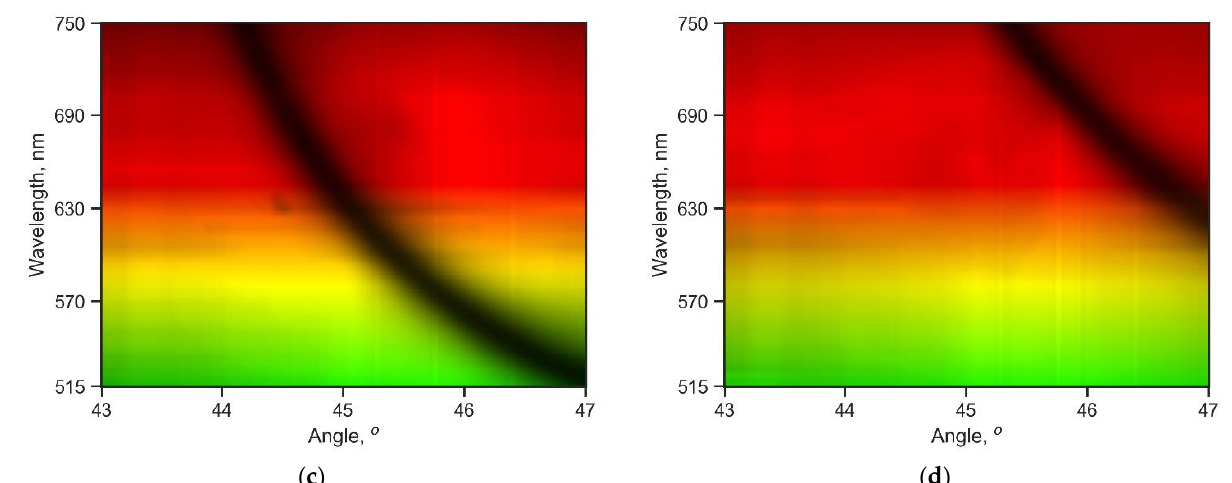
Figure 2. Experimental spectral images of the resonance curves (dependence of the reflection coef- ficient R on the angle of incidence θ ) for the LC-7 glass prism with the thin 55 nm silver film and various thicknesses of the dielectric coating (silicon dioxide). The color corresponds to the real color visible to the human eye. The thickness of the dielectric coating measured by the spectrophotometer is ( a ) 0 nm, Sample 1; ( b ) 13 nm, Sample 2; ( c ) 17 nm, Sample 3; and ( d ) 30 nm, Sample 4.